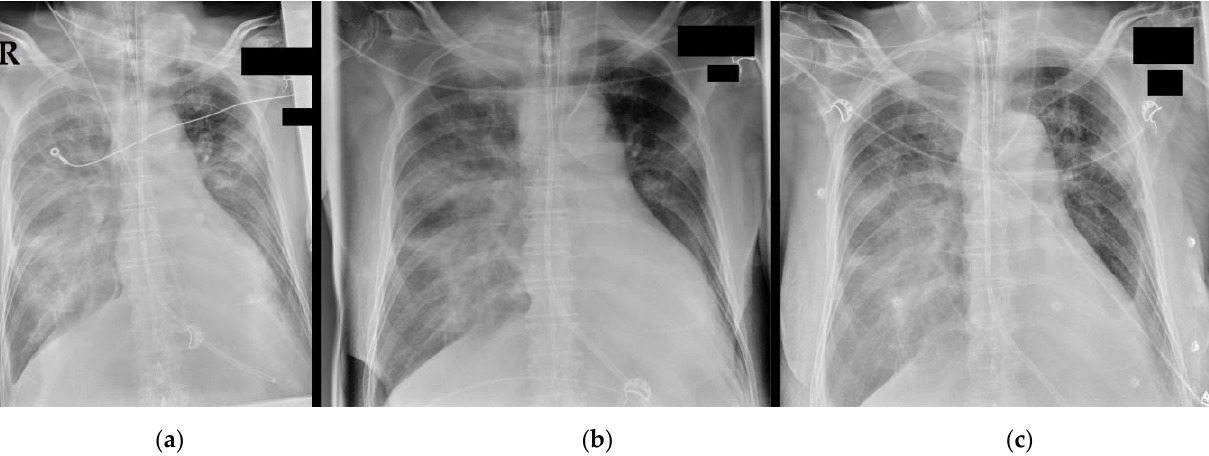
Figure 1. Chest X-ray at admission to the emergency department: Chest X-rays at ( a ) admission, ( b ) +14 h, and ( c ) +34 h. The endotracheal tube was detectable cranial of the carina, a gastric tube was placed, and from ( b ), a central venous catheter was inserted into the left internal jugular vein. Bilateral consolidations are compatible with pneumonic infiltrations and congestion. Bilateral pleural effusions can unfortunately not be optimally described due to the condition of the shot. The left upper lateral lobe shows the known bronchial tumour. R = right patient side.